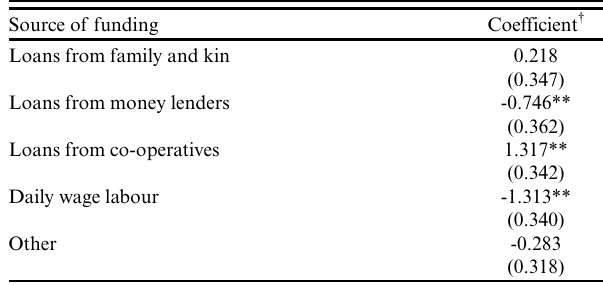
Table 7 . The effect (coefficient) of land ownership on the probability of farmers funding costs of cultivation from different